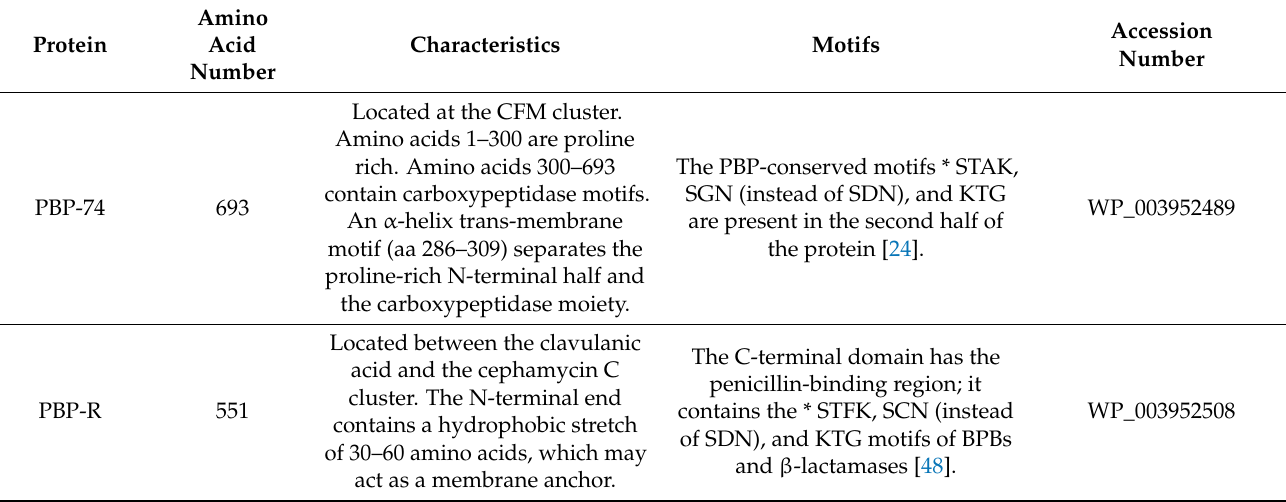
Table 1. PBPs and β -lactamases encoded by genes in S. clavuligerus CFM-CA